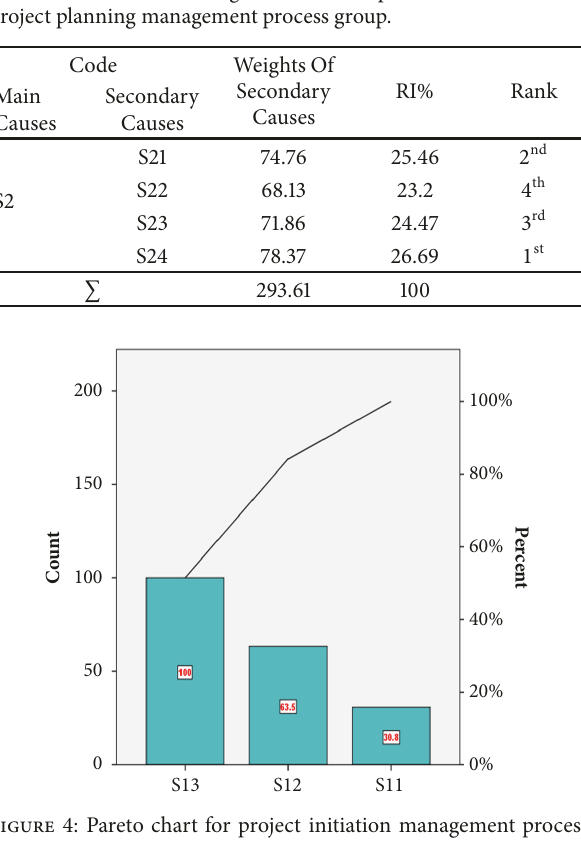
Figure 4: Pareto chart for project initiation management process group.